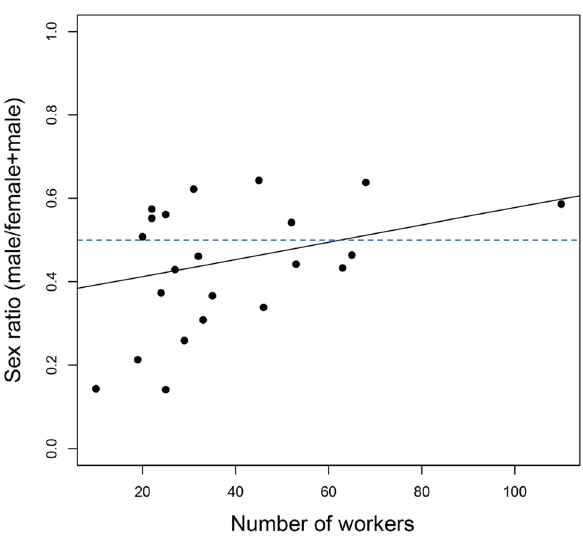
Figure 5. The relationship between the number of workers and sex ratios (proportion of males). The GLM indicated significant differences (see also Tables